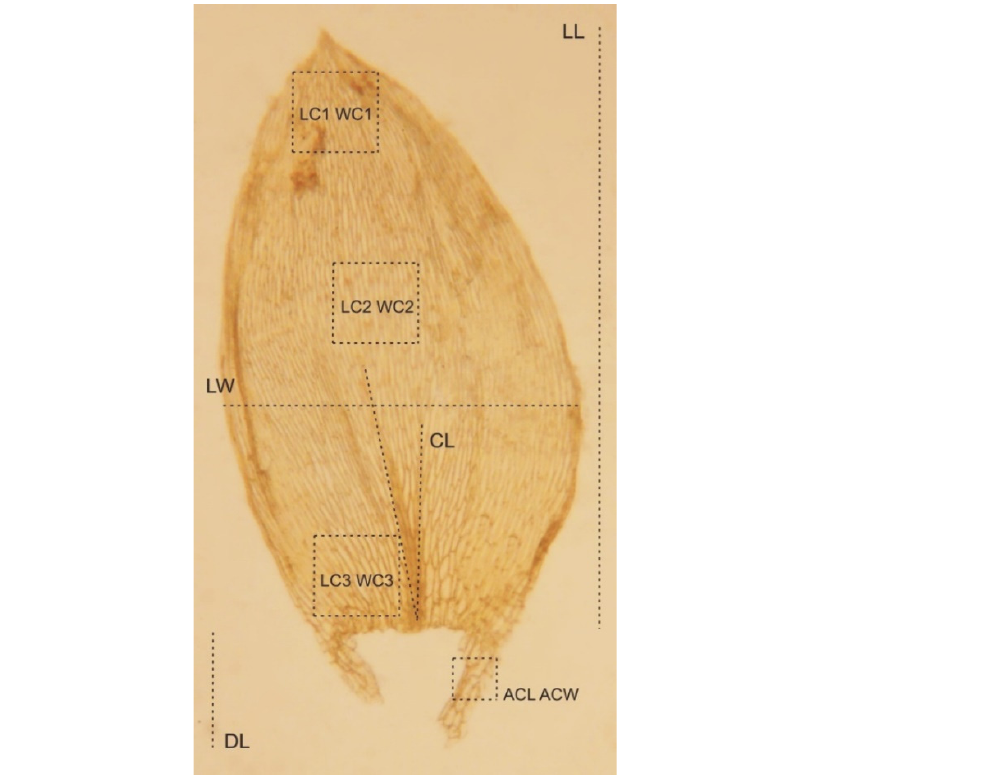
Figure 18. Location of the characteristics studied on the leaf. Illustration from the original materials of H . denticulatum var. obtusifolium (BM000890810) by G.J. Wolski, April 2022. In the case of the leaf length and width (LL, LW); length and width of cells from the top (LC1, WC1), the middle part (LC2, WC2), and from the lower part of the leaf (LC3, WC3); the length and width of alar cells (ACL, ACW); average costae length (CL;) and the decurrency length (DL) were included in the mathematical analysis. Therefore, to visual- ize the differences or similarities between the groups, box plot diagrams are presented. All analyses were performed using STATISTICA software (version 13.3.7). All specimens of P . sandbergii included in the statistical analyses were collected by rate specimens (PC0132604, PC0132605) (Figures 7 and 8), any data obtained for them were summed and referenced jointly as representing a single taxon.